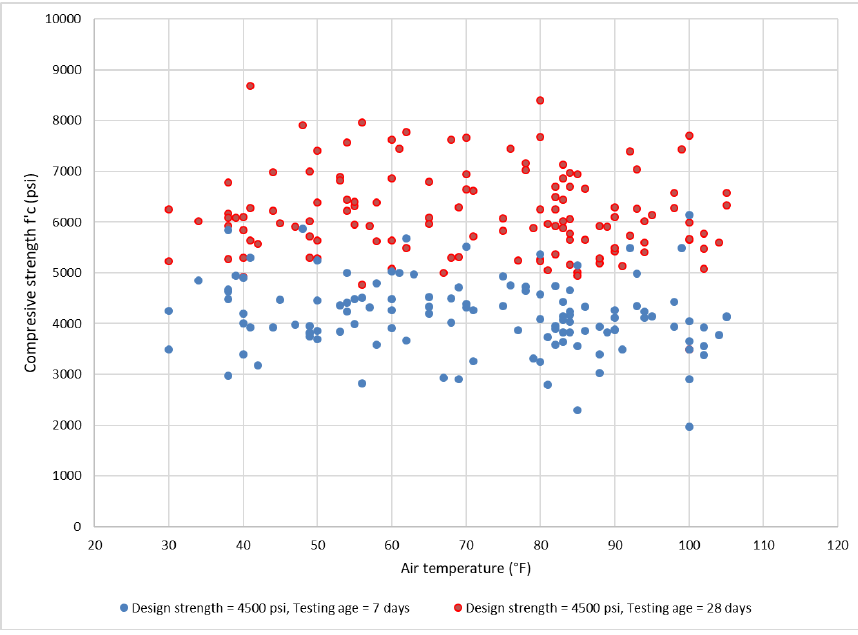
Figure 2. Relation between compressive strength and air temperature for a design strength of 4500 psi.